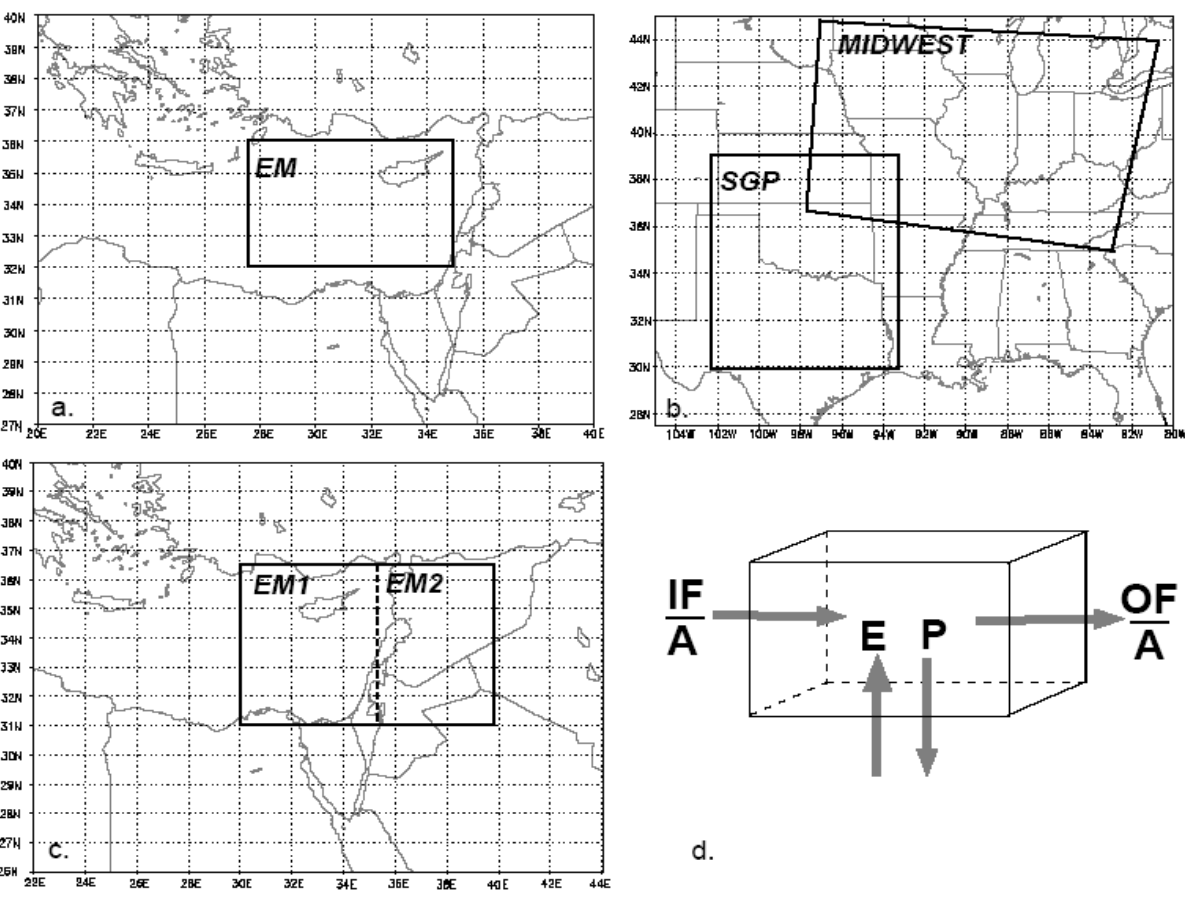
Fig. 1. Orientation map. Delineated approximately rectangular regions formed the bases of atmospheric volumes illustrated in (d) for which moisture budget components were estimated. (a) Eastern Mediterranean (EM), (b) US Midwest (MW) and Southern Great Plains (SGP), (c) coastal (EM1) and inland (EM2) eastern Mediterranean regions, (d) WVB components symbols for atmospheric volume as in Eq. (3). Table 1. Area and normalization information for study regions named in Sect. 2.3 and delineated in Fig. 1. The normalization area A 0 used (0.7 × 10 6 km 2 ) was close to the mean of the North Amer- ican regions and the eastern Mediterranean regions to which it was √ √ A/ A 0 applied. The normalization factor L/L 0 was obtained as where A is the area of each region. See Sect. 2.3 for underlying theory.